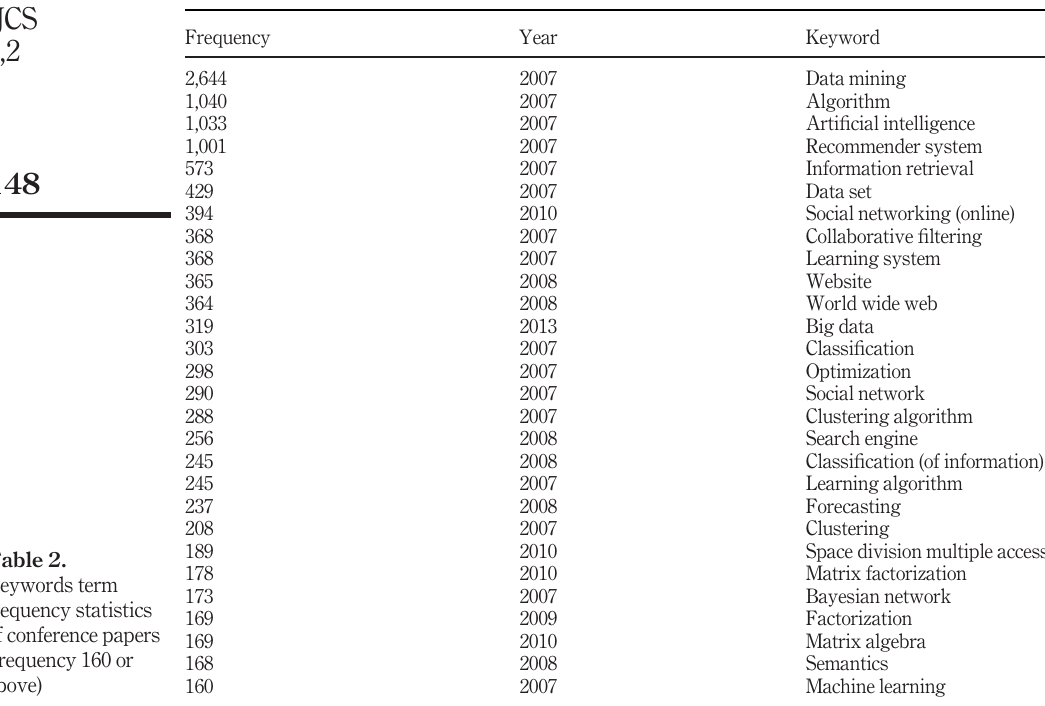
Table 2. Keywords term frequency statistics of conference